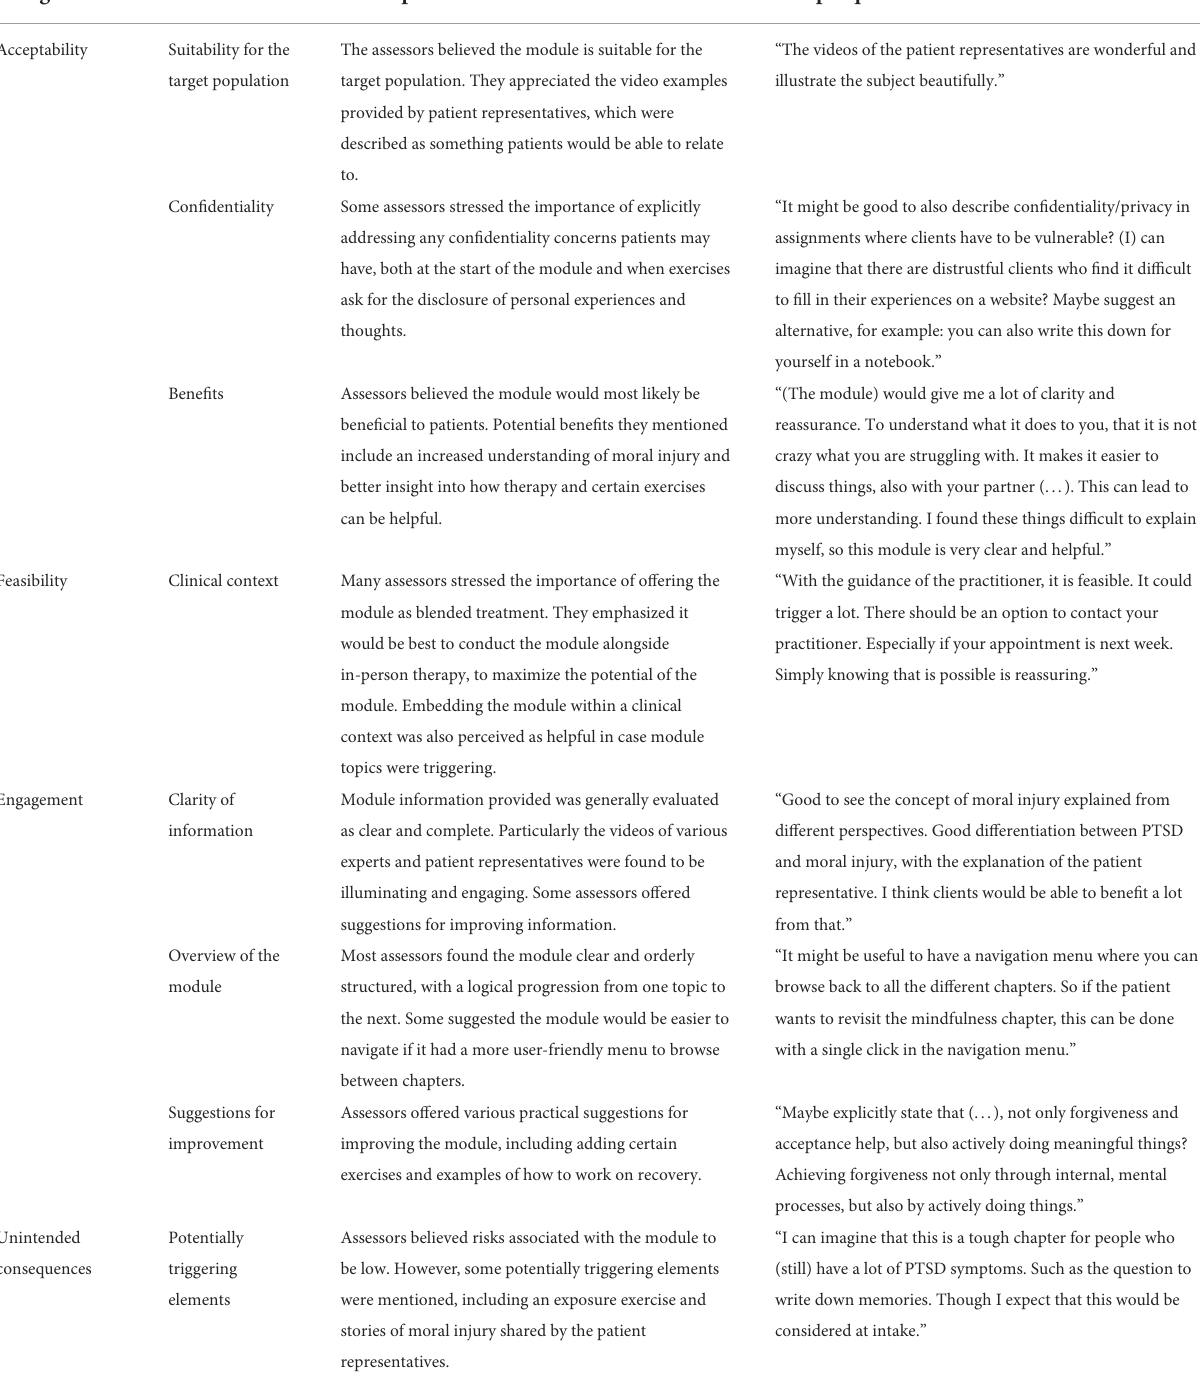
TABLE 1 Sample quotations illustrating feedback categories and